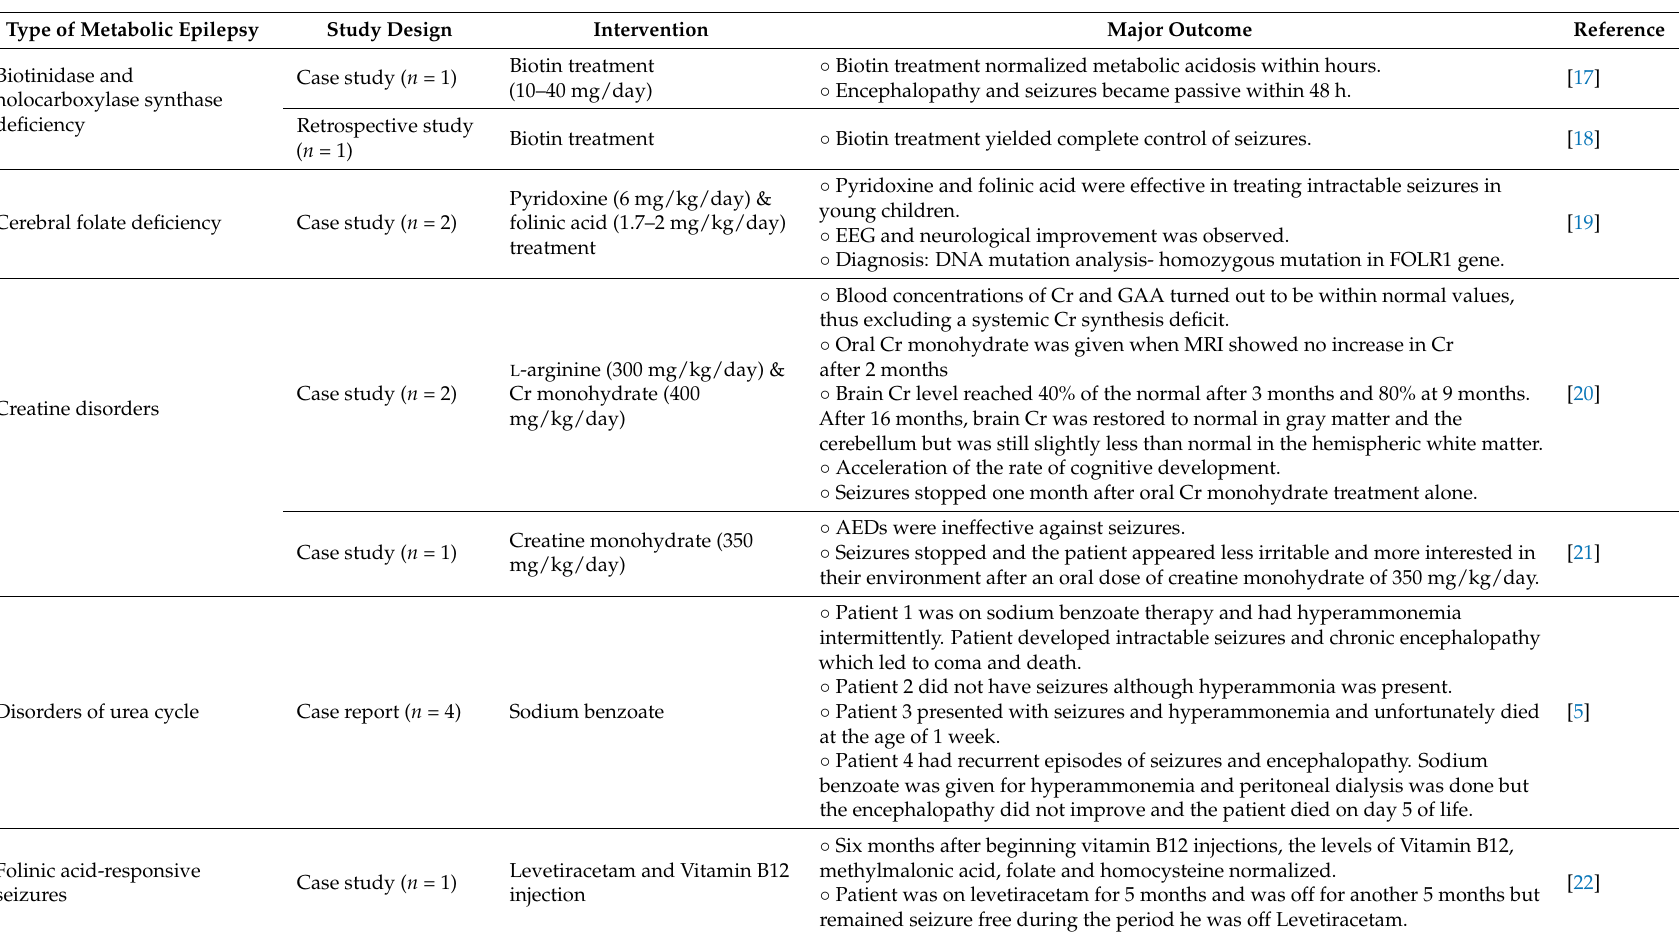
Table 1. Study data categorized based on the different types of metabolic